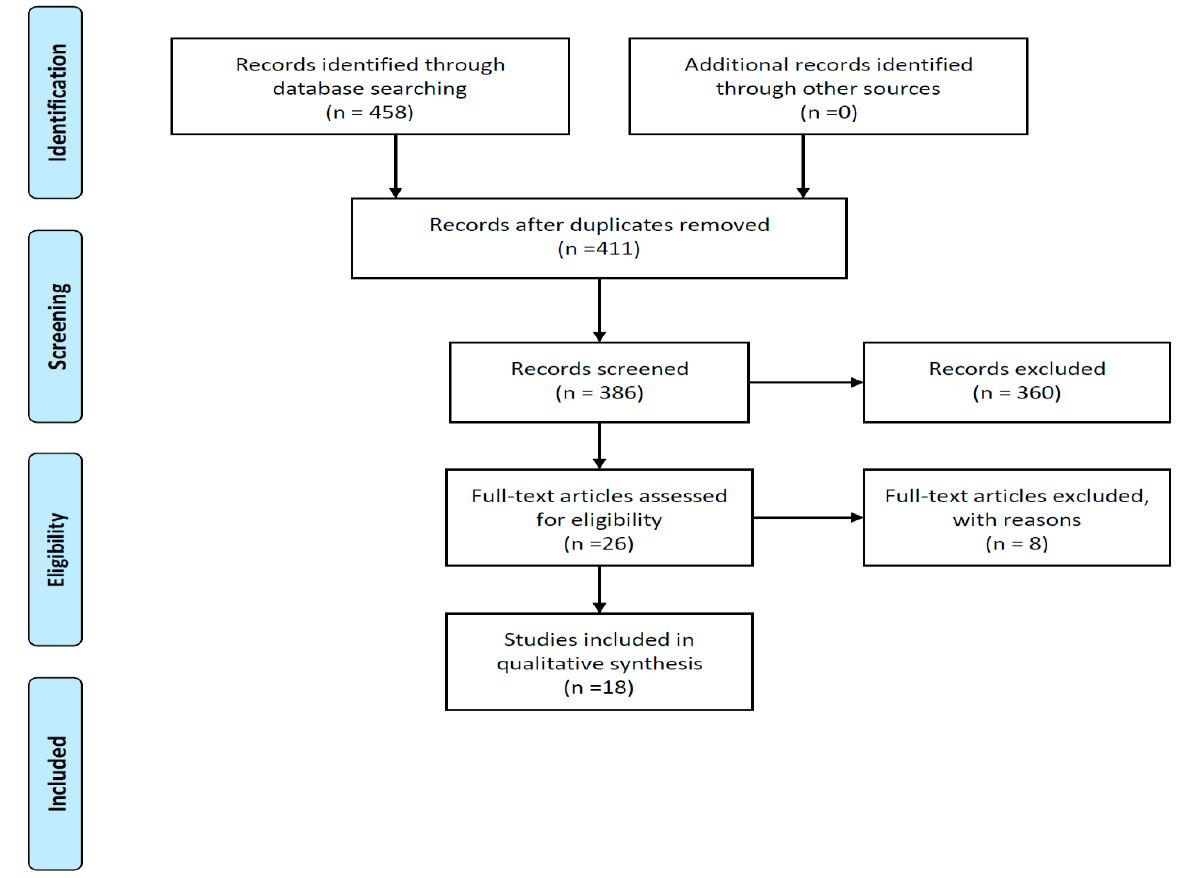
Figure 1. PRISMA flow diagram indicating record numbers for final inclusion (Moher et al., 2019 [9]).